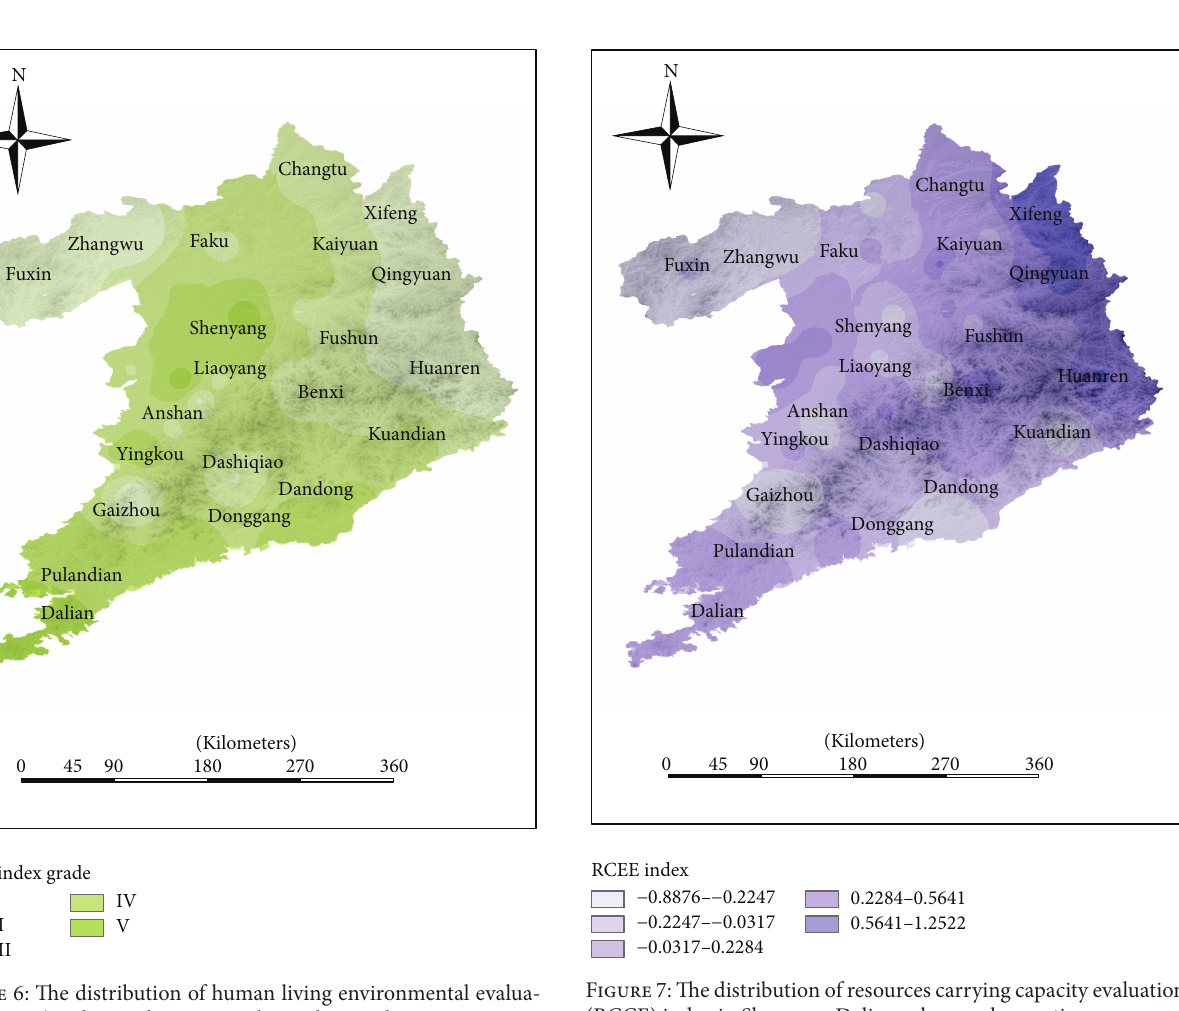
Figure 7: The distribution of resources carrying capacity evaluation (RCCE) index in Shenyang-Dalian urban